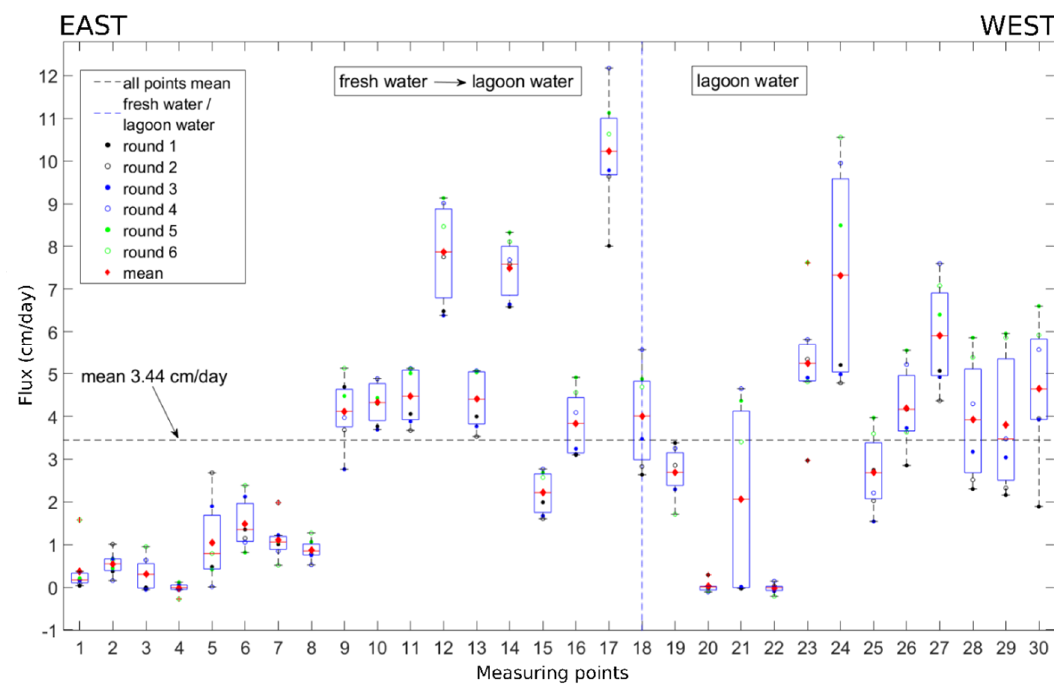
Figure 4. The exchange fluxes corresponding to the seepage meter experiments for each round of measurements at each measuring point. The red diamond corresponds to the mean value. The black dashed line shows the mean flux for all locations and all rounds. The blue dashed line points to the location from which no fresh water was found in the water samples to the left of this line (see Section 3.4).